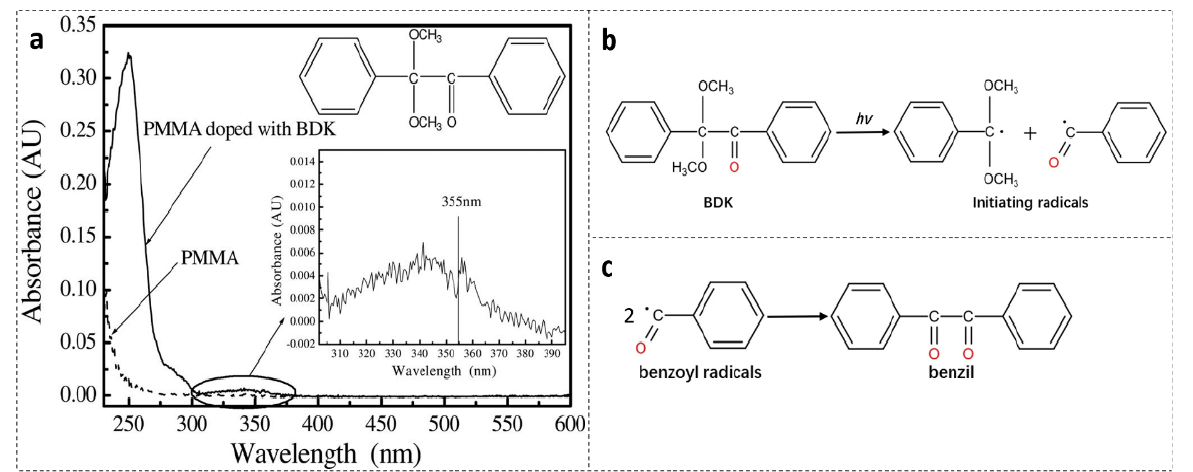
Figure 1. ( a ) Absorption spectra of PMMA and BDK ‐ doped PMMA, the inset shows the zoomed ‐ in absorption spectrum from 302 to 395 nm. Reprinted with permission from [19]. ( b ) Structure change of BDK under UV irradiation [20,21]; ( c ) Formation of benzil molecules from benzoyl radicals generated under UV irradiation on BDK [20,21].